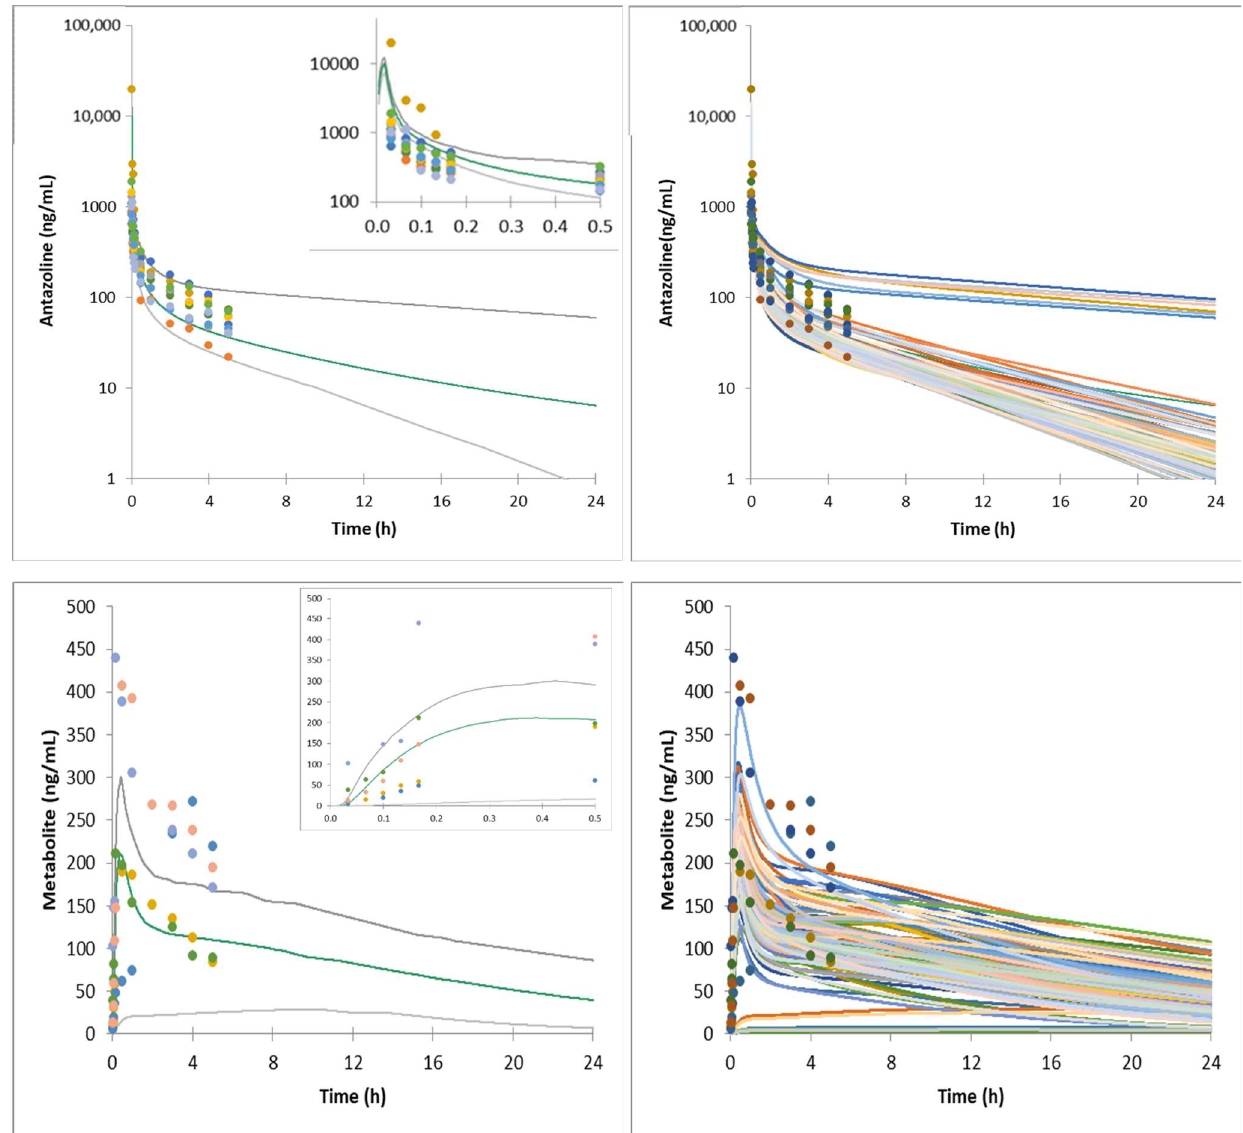
Figure 1. Mean and individual simulated systemic plasma concentration profiles of antazoline and its metabolite following 100 mg of antazoline infusion (healthy volunteers, ELEPHANT I study). Dots—observed individual data; gray lines—5th and 95th percentile; green line—simulated average concentration; colour lines—simulated individual concentrations. Insert—data for the first 30 min after dosing.